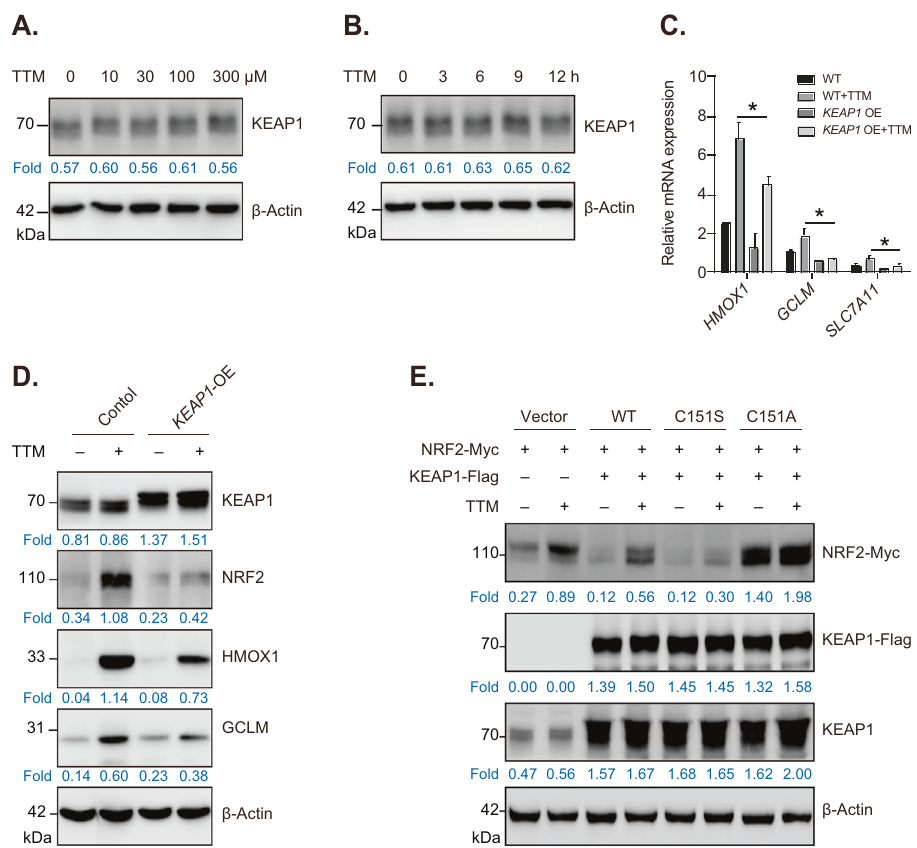
Fig. 2 KEAP1 is involved in NRF2 pathway activation in TTM-treated HUVECs. A Western blot analysis and quanti fi cation of KEAP1 in 0, 10, 30, 100, or 300 μ M TTM-treated HUVECs. β -Actin was used as loading control. B Western blot analysis and quanti fi cation of KEAP1 and GAPDH in HUVECs treated with TTM (100 μ M) for 0, 3, 6, 9, and 12 h, respectively. C qPCR analysis mRNA levels of HMOX1 , GCLM , SLC7A11 in KEAP1 -OE cells treated with or without TTM. One-way ANOVA followed by a Tukey multiple comparison test was used for statistical analysis. * p < 0.05. D Western blot analysis and quanti fi cation of KEAP1, NRF2, HMOX1, and GCLM in KEAP1 -OE cells treated with or without TTM. β -Actin was used as loading control. E Plasmid vectors expressing KEAP1-Flag (WT), KEAP1-Flag (C151S) or KEAP1-Flag (C151A) were co-transfected with NRF2-Myc into Hela cells for 48 h and then treated with or without 100 μ M TTM for 12 h. Western blot analysis and quanti fi cation of protein levels of exogenous NRF2-Myc, KEAP1-Flag and endogenous KEAP1. β -Actin was used as loading cell sorting (FACS) data were analyzed by FlowJo ™ v10 Software BD Biosciences (San Jose, CA, USA). Statistical analysis Each experiment was repeated for at least three times with similar results obtained. Data are presented as mean ± standard deviation (S.D.). Unpaired Student ’ s t test and one-way ANOVA followed by Tukey multiple comparison test were used for statistical analysis in this study. * p < 0.05 was considered statistical signi fi cance. All statistical tests were performed using GraphPad Prism 9.3 (GraphPad Software, San Diego, CA, USA).